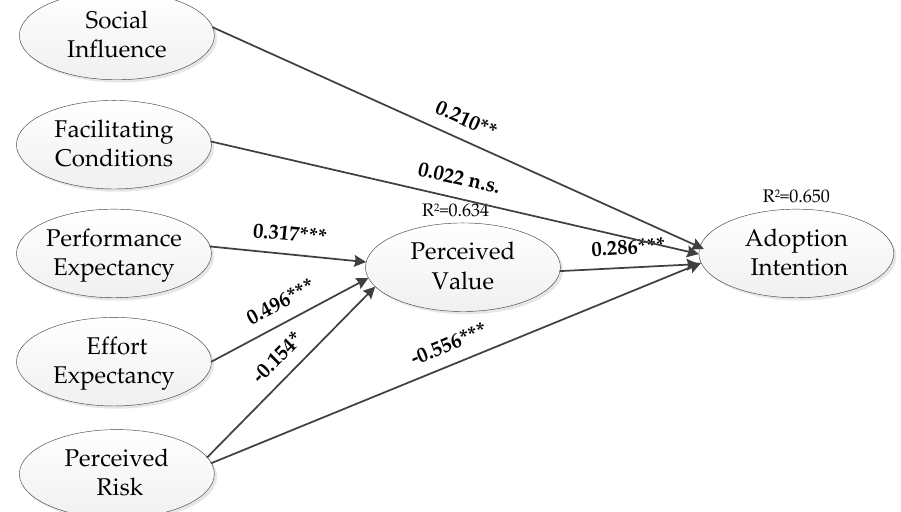
Figure 2. The results of the FinTech adoption model. Note: *** p < 0.001; ** p < 0.01; * p < 0.05; n.s.: no significance.